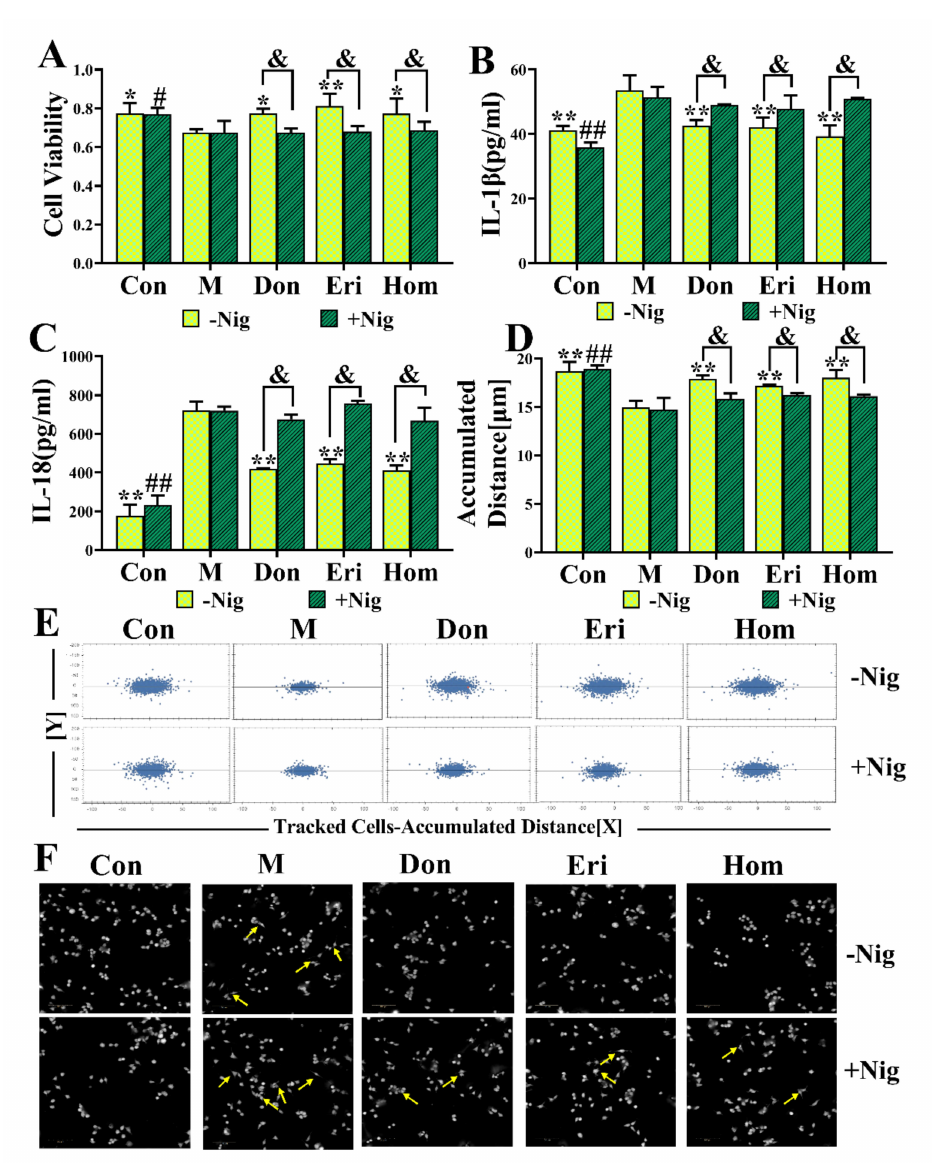
Figure 7. Eri and Hom inhibit N9 microglia via the NLRP3 inflammasome. ( A ) Cell viability was measured by MTT assay. N9 cells were treated with the Donepezil (10 µ mol/L + 1 ug/mL LPS) group; Eri (10 µ mol/L + 1 ug/mL LPS) group; and Hom (10 µ mol/L + 1 ug/mL LPS) group; this effect disappeared after Nigericin (10 µ mol/L) stimulation, n = 4. ( B , C ) Measure the levels of IL-1 β and IL-18 in the supernatant of the N9 cells according to the instructions of the kit, n = 4. ( D – F ) N9 cells migration ability and morphology changes detected via High Content Screening System, n = 6. The data were expressed as the mean ± SD. * p < 0.05, ** p < 0.01 compared with the M group; # p < 0.05, ## p < 0.01 compared with the M group (Add Nigericin). & p < 0.05, Compared with the agonist group. Con means the control, M means the model, Don means the donepezil, Eri means the eriodictyol, Hom means the homoeriodictyol, Nig means the